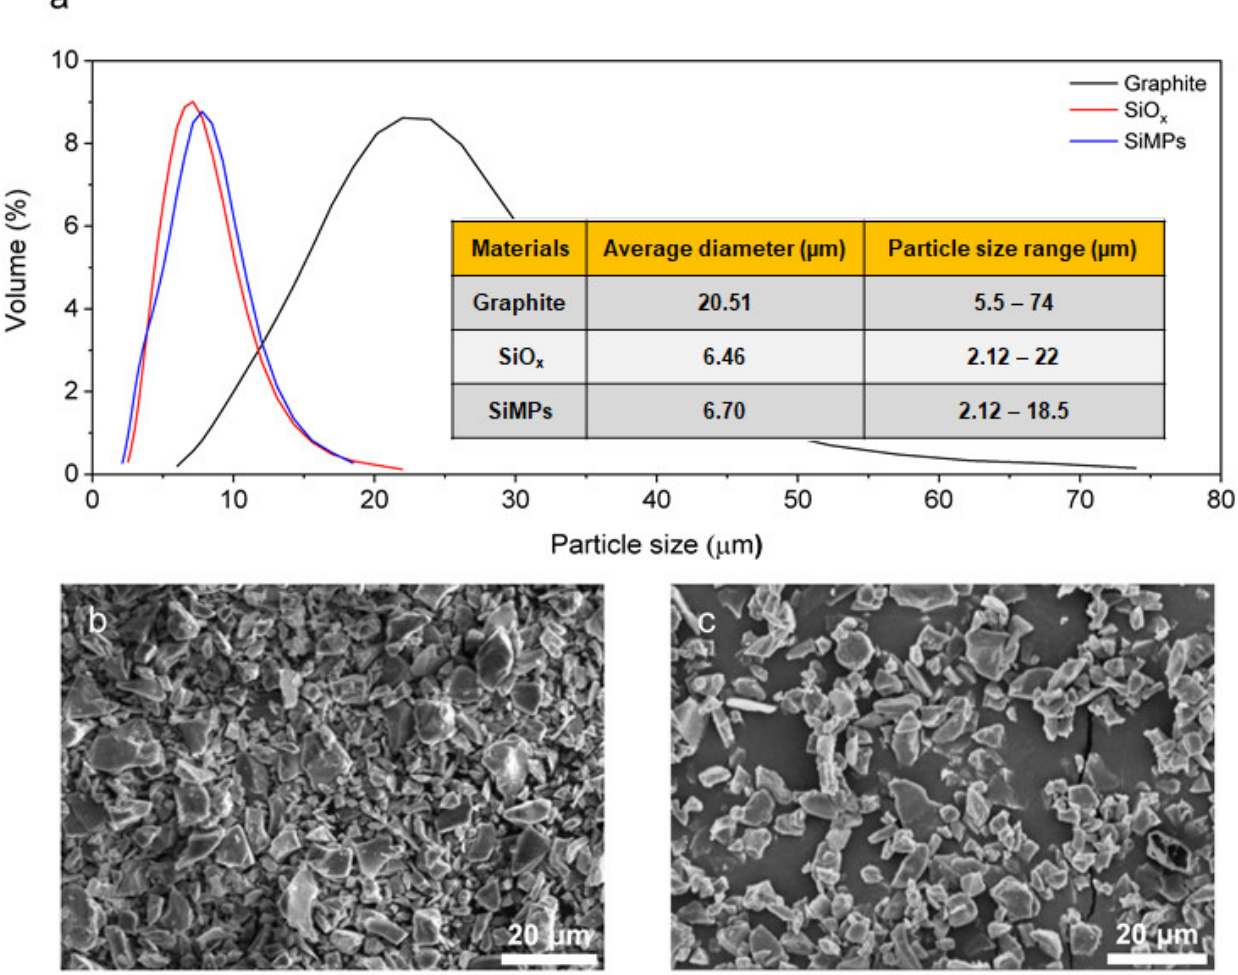
Figure 1. ( a ) Particle size distribution of graphite, SiO x , and SiMPs. SEM images of ( b ) SiMPs and ( c ) SiO x .